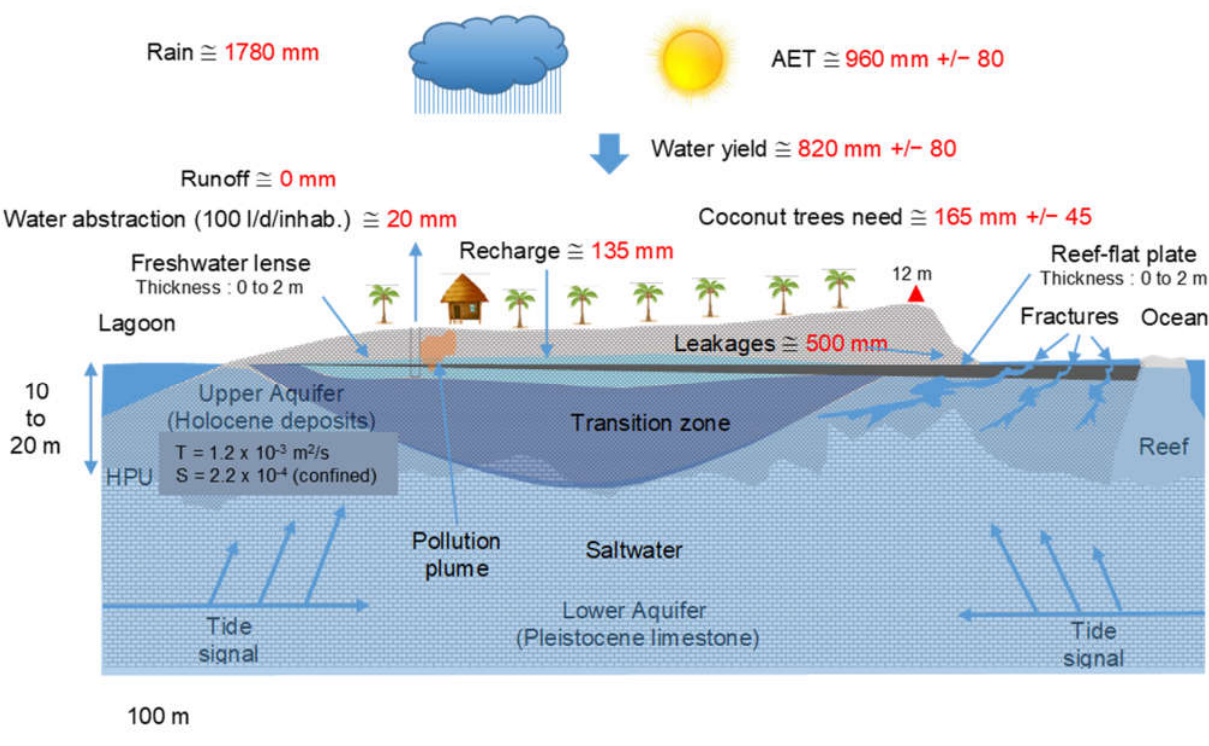
Figure 8. Hydrogeological conceptual model of Rangiroa atoll (modified after ref. [2]). The atoll receives about 1800 mm/year of rainfall, most of it during the period between November and February. The actual evapotranspiration calculated for an assumption of S max = 20 mm (low value related to the rather coarse soil type with reduced clay fraction) is 1000 ± 80 mm/year. This evapotranspiration corresponds to an assessment made for reference vegetation, but the high density of coconut trees on the atoll probably induces an excess of evapotranspiration estimated at 165 mm/year.